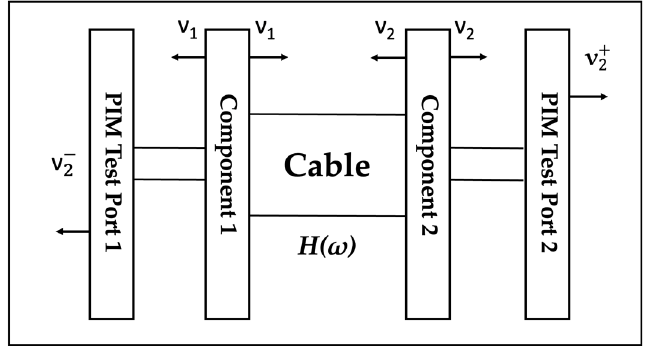
Figure 4. PIM response model of point source.